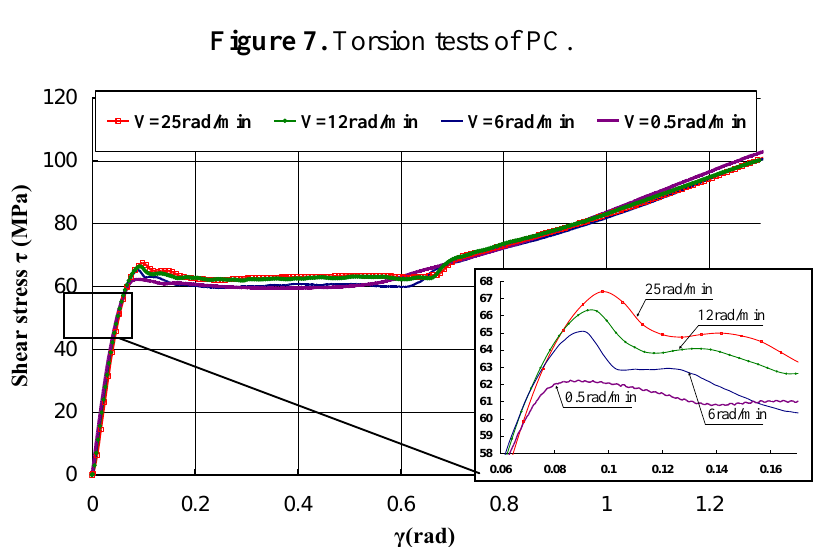
Figure 7. Torsion tests of